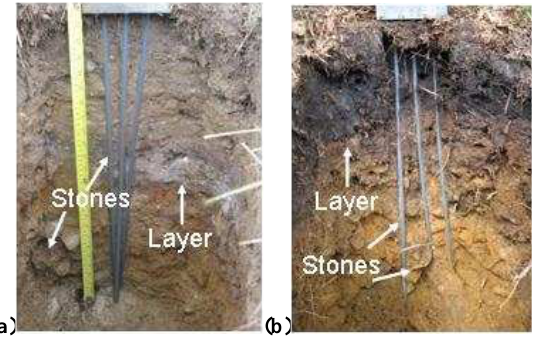
Fig. 1: Typical soil profiles with different horizons and coarse gravel and possible deformations of the TDR wave guides when installed in the soil (A and B).